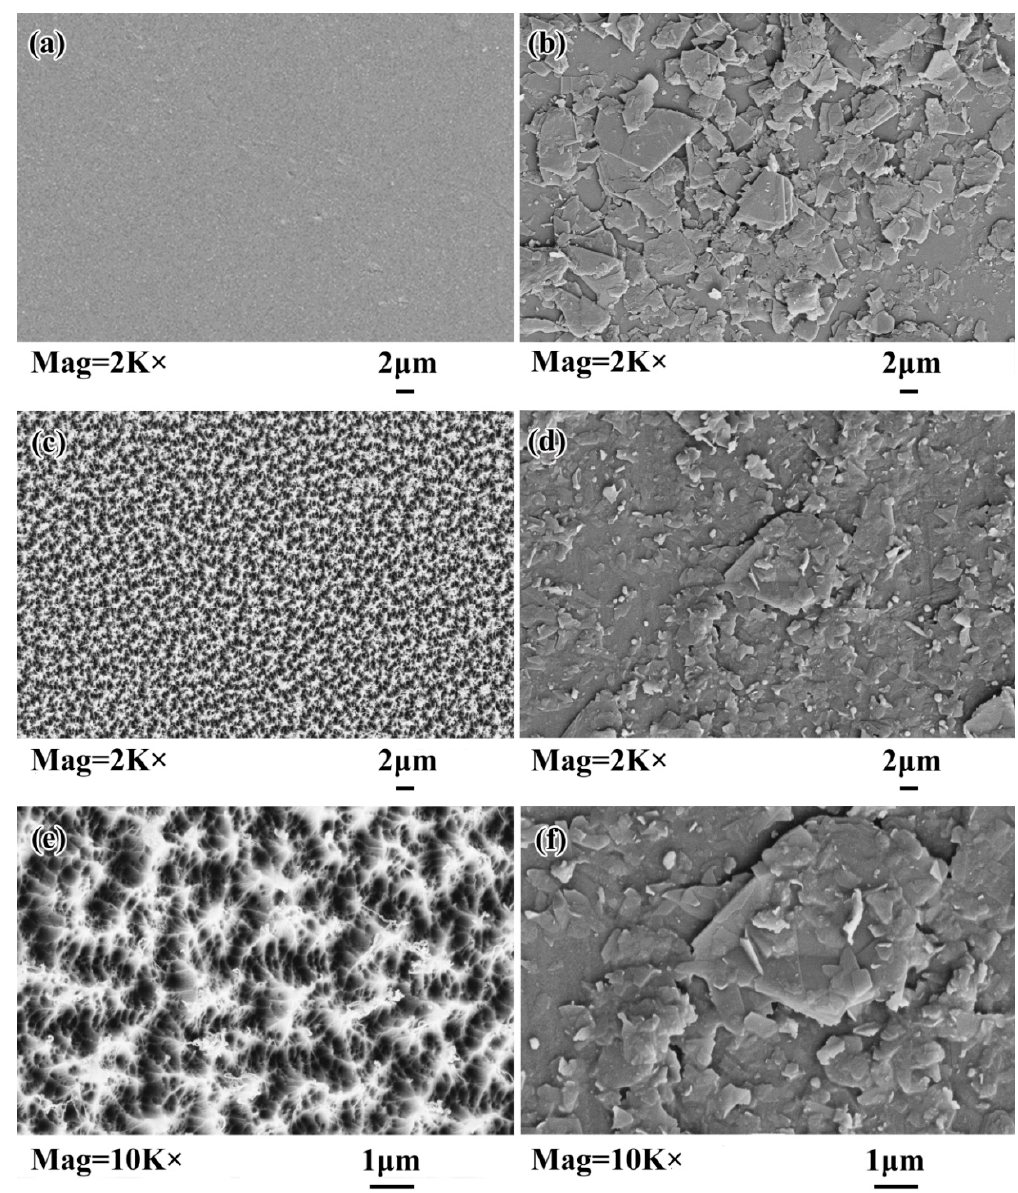
Figure 10. ( a ) SEM images of Kapton before AO erosion; ( c , e )SEM images of Kapton after AO Figure 10. ( a )SEM images of Kapton before AO erosion; ( c )( e )SEM images of Kapton after AO erosion; ( b ) SEM images of coated Kapton with graphene loading 26.0 µ g / cm 2 before AO erosion; erosion; ( b ) SEM images of coated Kapton with graphene loading 26.0 μ g/cm 2 before AO erosion; ( d ) ( d , f ) SEM images of coated Kapton with graphene loading 26.0 µ g / cm 2 after AO erosion (AO flux: ( f ) SEM images of coated Kapton with graphene loading 26.0 μ g/cm 2 after AO erosion (AO flux: 7.09 × 7.09 × 10 20 atoms / cm 2 10 20 atoms/cm 2 ).